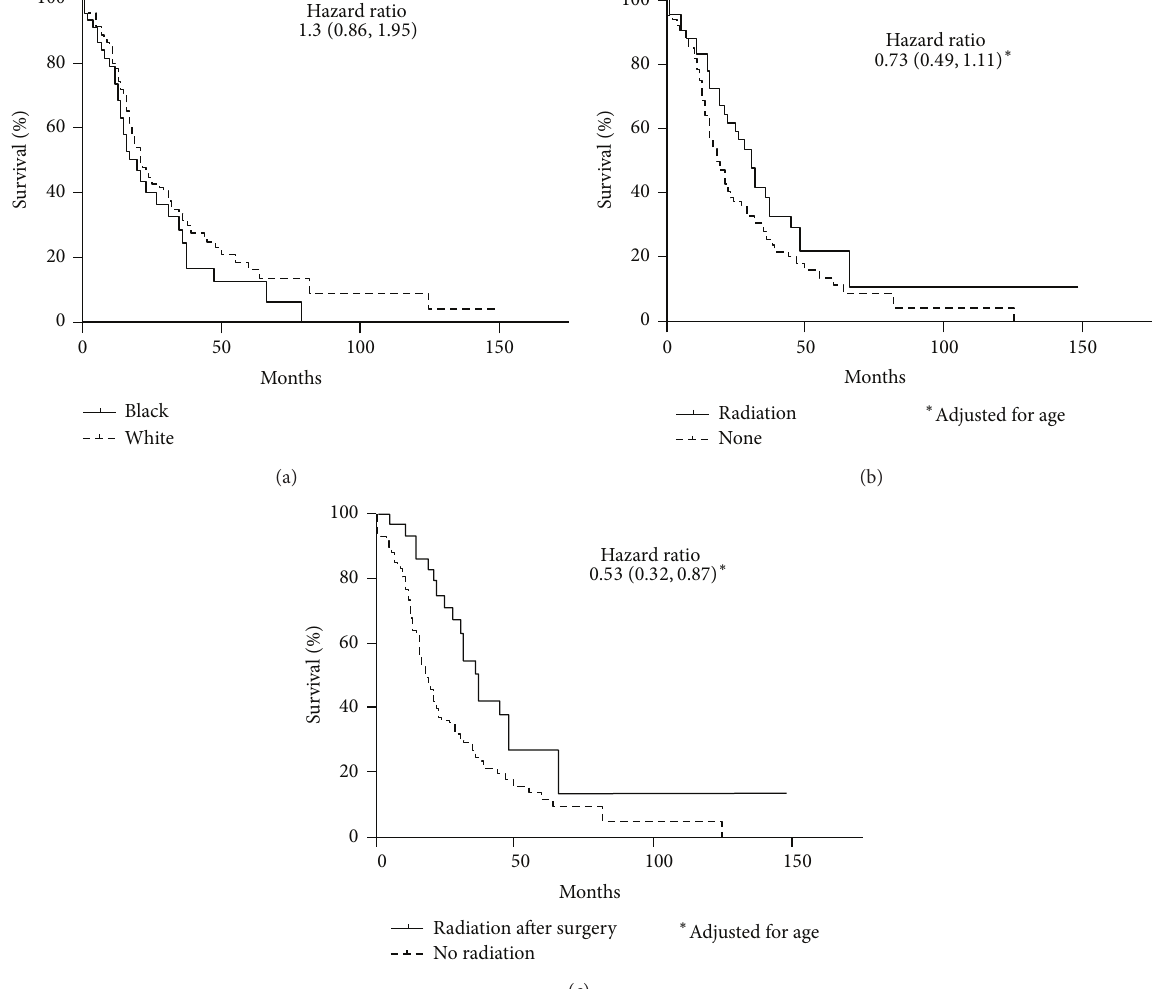
for Caucasians, African-Americans, American Indians, and Asian Pacific Islanders were 0.2, 0.5, 0.3, and 0.1 cases/million, respectively (data not shown), with a statistically significant difference between Caucasians and African-Americans ( 𝑃 =